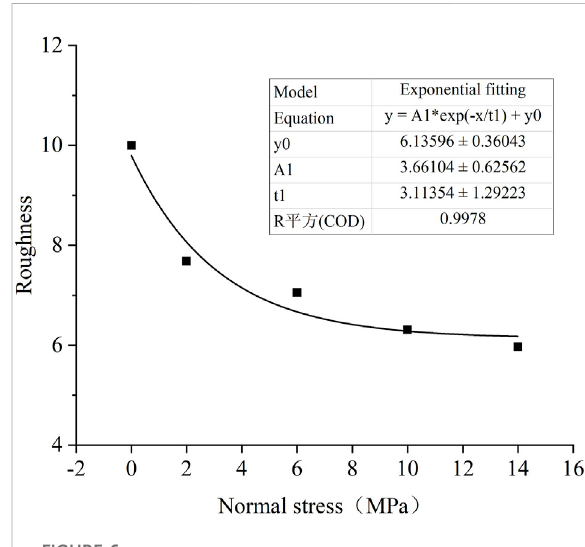
FIGURE 6 JRC value of the structural plane after shear under different normal